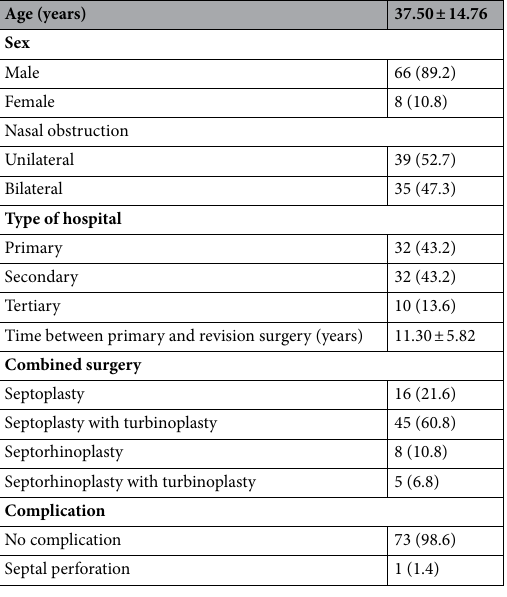
Table 1. Patient characteristics. Data are expressed as the number (percentage) except age and time (means ± standard deviation).